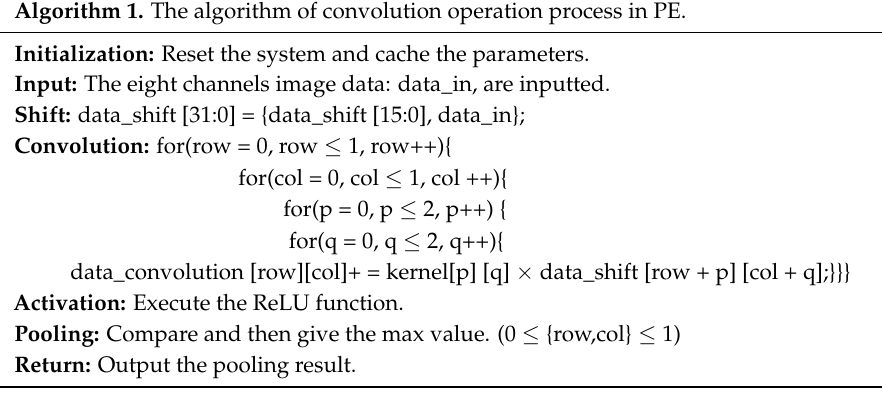
Algorithm 1. The algorithm of convolution operation process in PE.